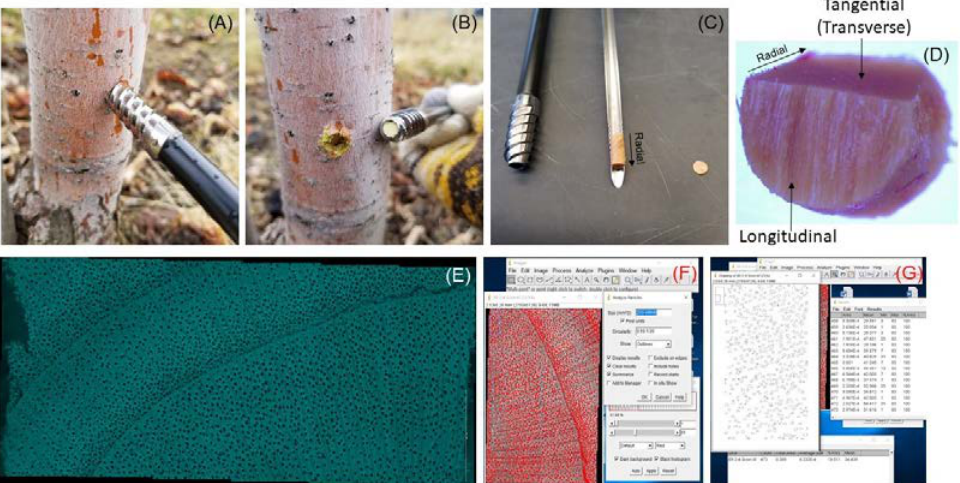
Figure 1. Xylem sample preparation and vessel element analysis. ( A , B ) Secondary xylem sample was collected from a living tree using an increment borer; ( C , D ) Transverse section of xylem sample